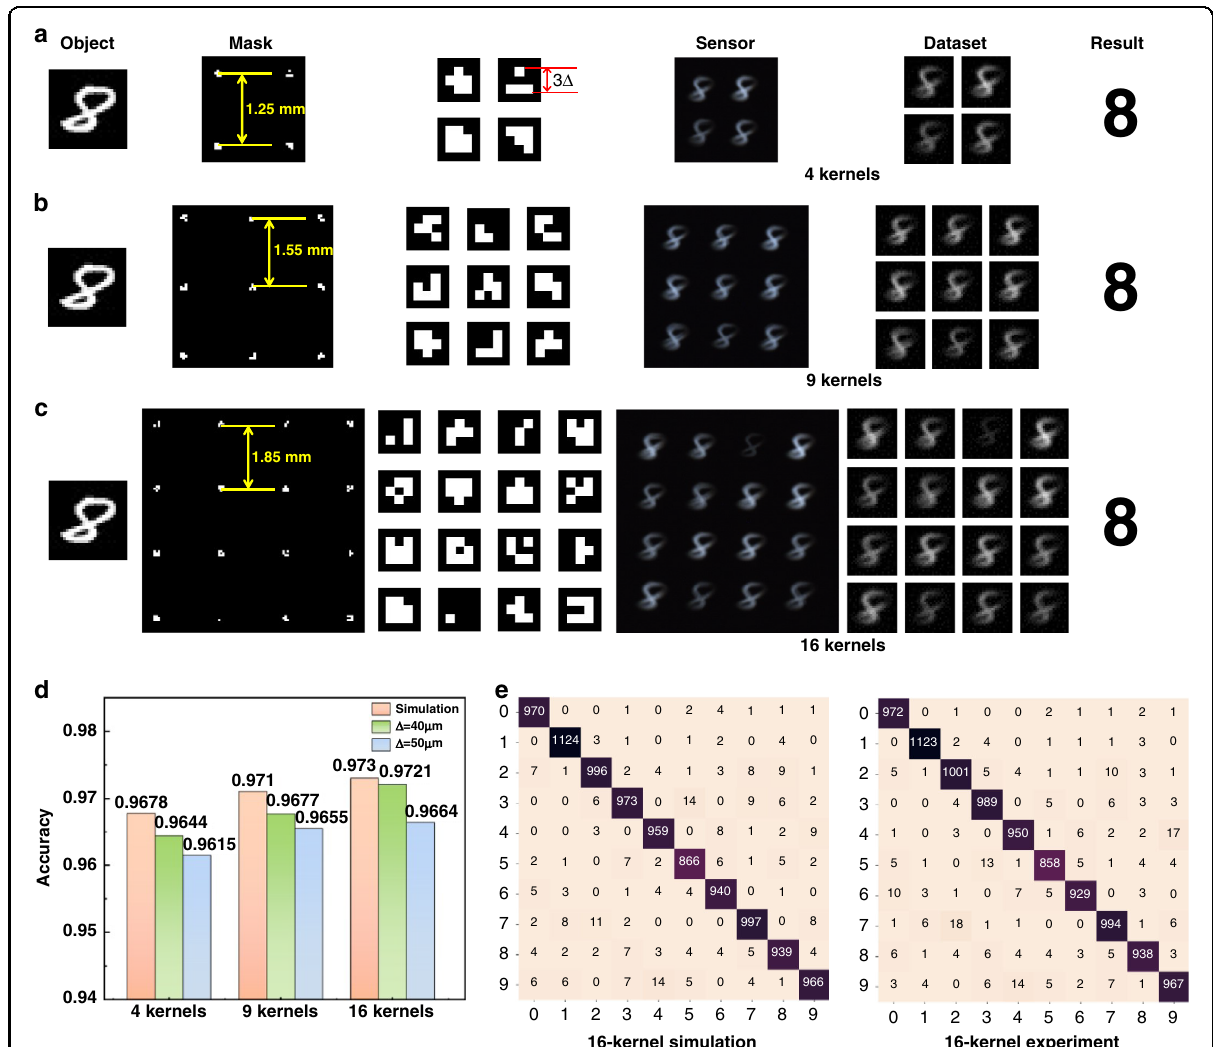
Fig. 7 Results for mutiple-kernel systems. Multiple-kernel convolution classi fi cation based on a 4 kernels, b 9 kernels, and c 16 kernels. d Recognition accuracy for multiple-kernel systems. e Confusion matrixes for 16-kernel convolution